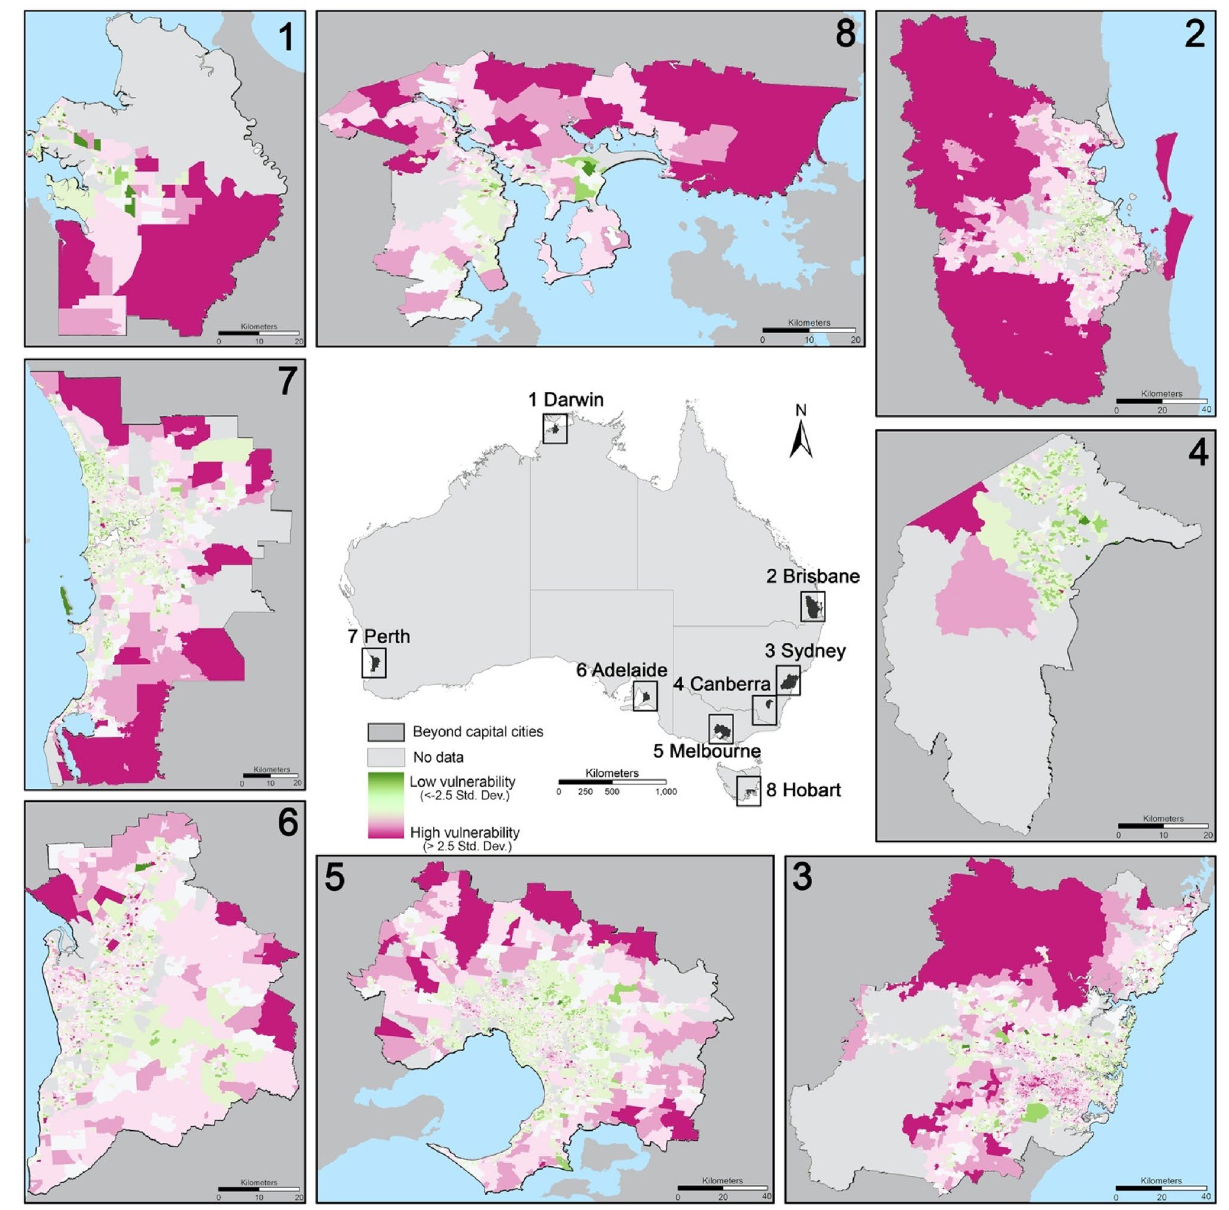
Figure 4. Spatial patterns of the vulnerability index in urban areas of eight capital cities: (1) Darwin (the capital city of Northern Territory); (2) Brisbane (the capital city of Queensland) ; (3) Sydney (the capital city of New South Wales); (4) Canberra (Australian Capital Territory (ACT)) ; (5) Melbourne (the capital city of Victoria); (6) Adelaide (the capital city of South Australia); (7) Perth (the capital city of West Australia); (8) Hobart (the capital city of Tasmania). The spatial patterns of the vulnerability index in each theme are displayed in Supplementary Figs. S2–S6. The identification of the most vulnerable urban areas (> 2.5 standard deviation) in different themes are presented in Supplementary Table S7. More specifically, for Theme 2 (Supplementary Fig. S3), the most vulnerable areas in terms of demographic composition and disability have less obvious patterns that can be generalised but more spread out sporadically across entire urban space outside of inner cities in Sydney, Brisbane, Adelaide, Perth, and ACT. For Theme 3 (Supplementary Fig. S4), the most vulnerable areas in terms of minority status and languages appear in Sydney (e.g., Liverpool and Blacktown), Melbourne (e.g., Springvale); in the south and southwest of Brisbane (e.g., Sunnybank, Sunnybank Hills); in Adelaide (e.g., Parafield), Perth (e.g., Jandakot) and Darwin (e.g., Humpty Doo). For Theme 4 (Supplementary Fig. S5), the most vulnerable areas in terms of housing types and transportation appear do not have specific patterns to generalise, but more sporadically appear in a few suburbs in each capital city (detailed in Supplementary Note 3). For Theme 5 (Supplementary Fig. S6), the most vulnerable areas in terms of built environment in capital cities share some common patterns—largely appearing in peri-urban locales, far away from inner